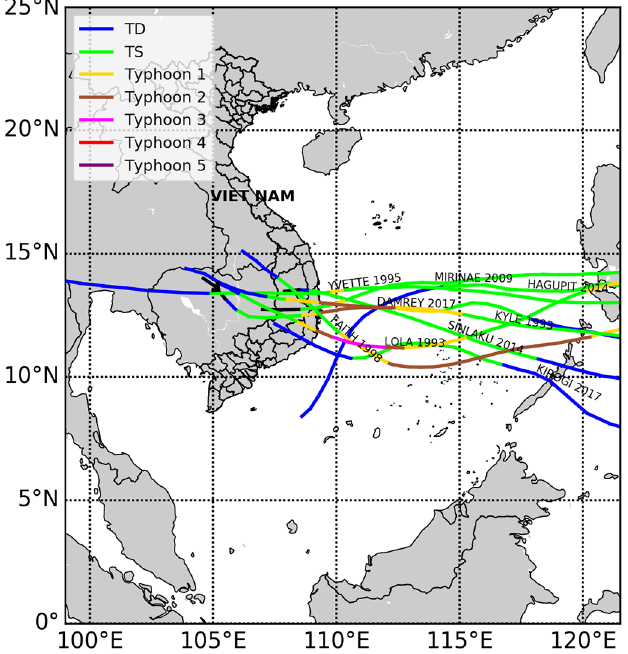
Fig. 8. Pathway of strong typhoons affecting VPB from 1951 to